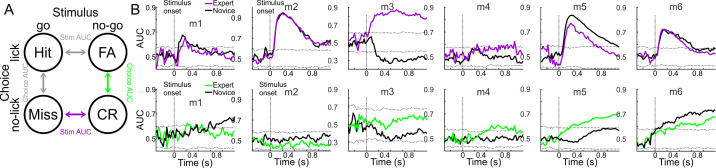
Stim-AUC and Choice-AUC based on other trial type pairs.(A) Schematic of alternative single trial discrimination measures using different trial types: Miss vs. CR (purple; Stim AUC) or FA vs. CR (light green; Choice AUC). Stim-AUCs (top) and choice AUCs (bottom) during the trial for all mice during novice (black lines) and expert (colored lines; purple for stim-AUC; Light green for choice-AUC). Dashed black lines display the mean ±3 s.t.d of AUC for trial shuffled data.